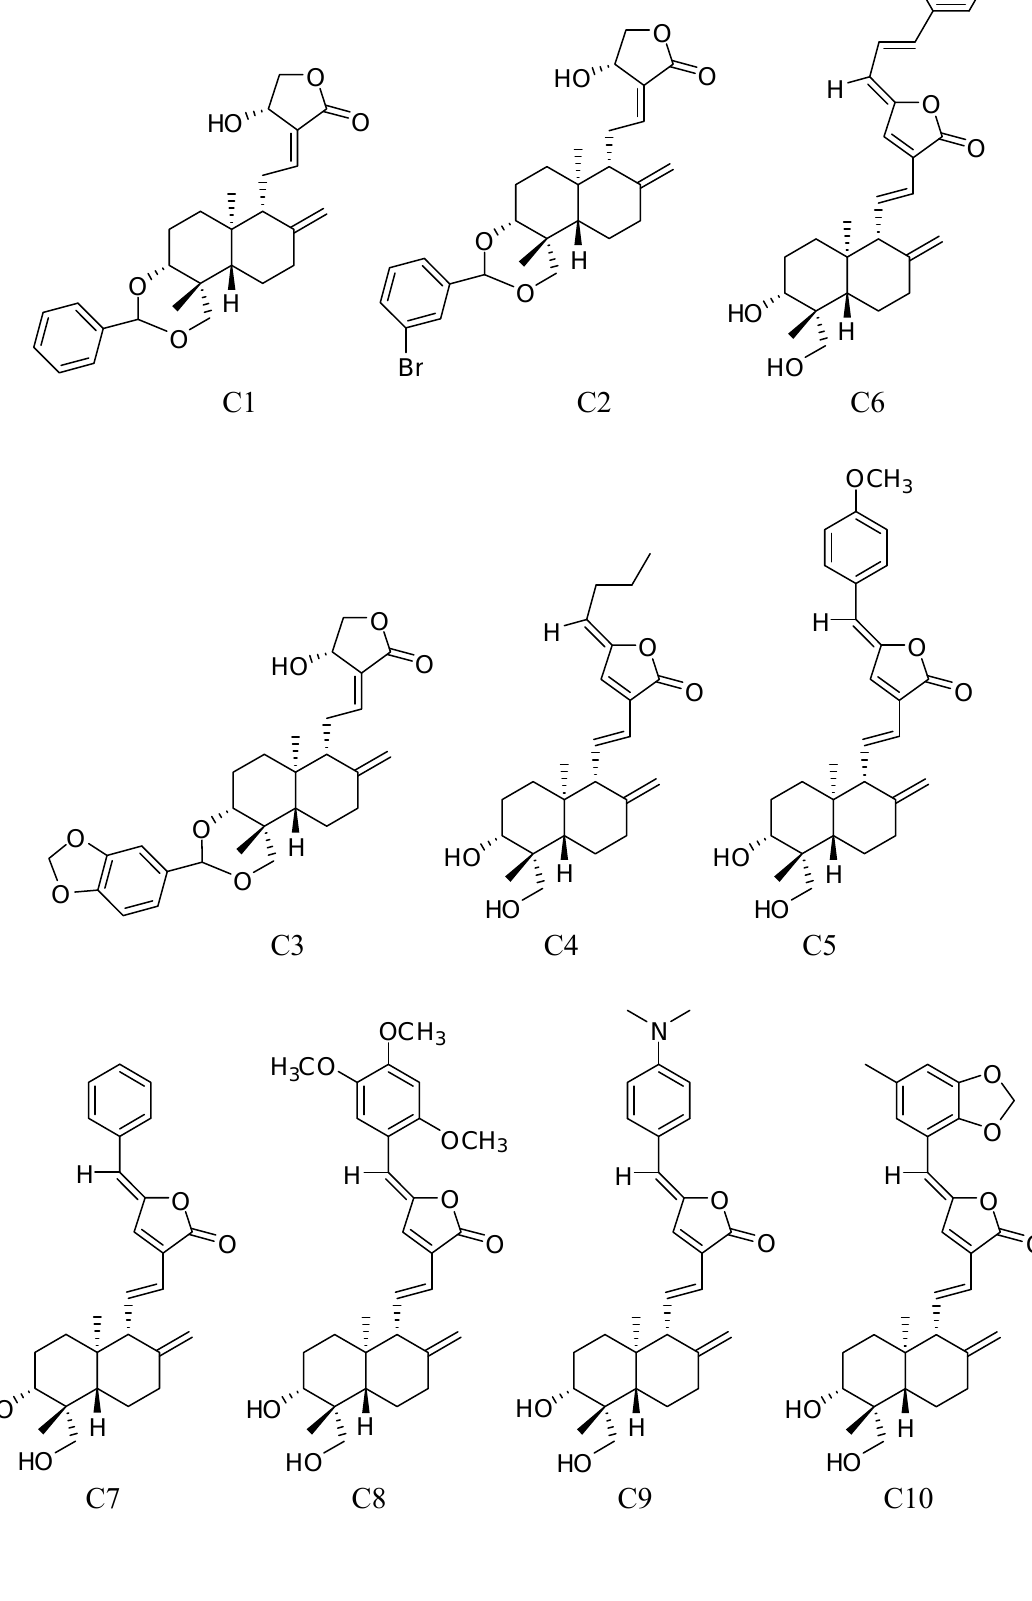
Figure 1. Formulae of the studied andrographolide